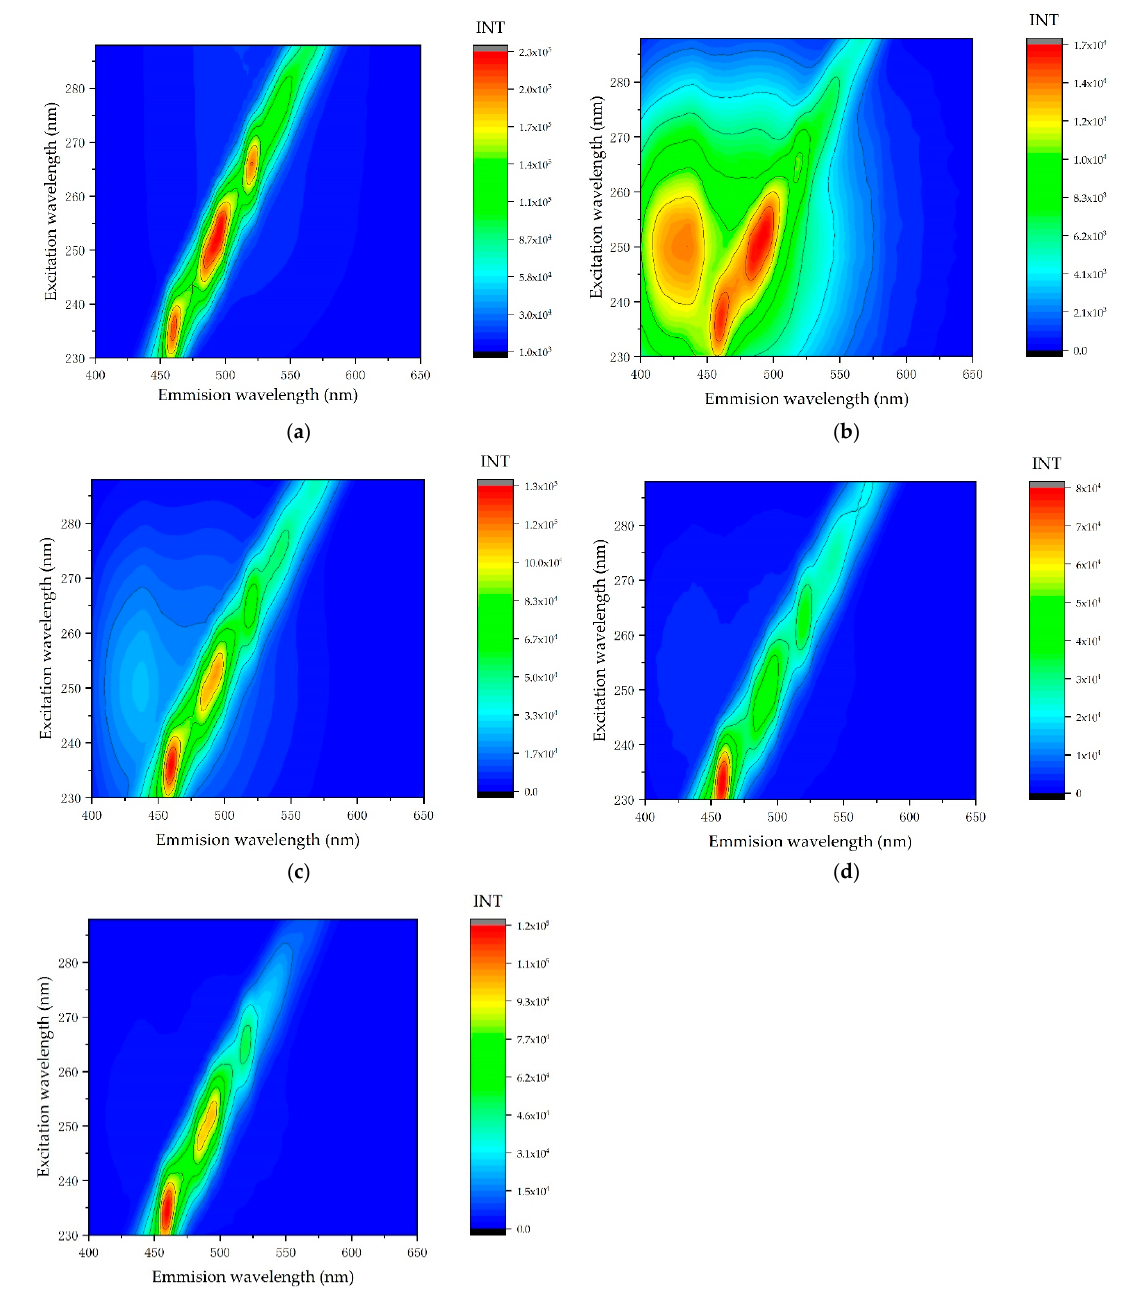
Figure 8. Three-dimensional fluorescence spectra of scheelite samples BWK1–5: ( a ) BWK1; ( b ) BWK2; ( c ) BWK3; ( d ) BWK4; ( e ) BWK5.